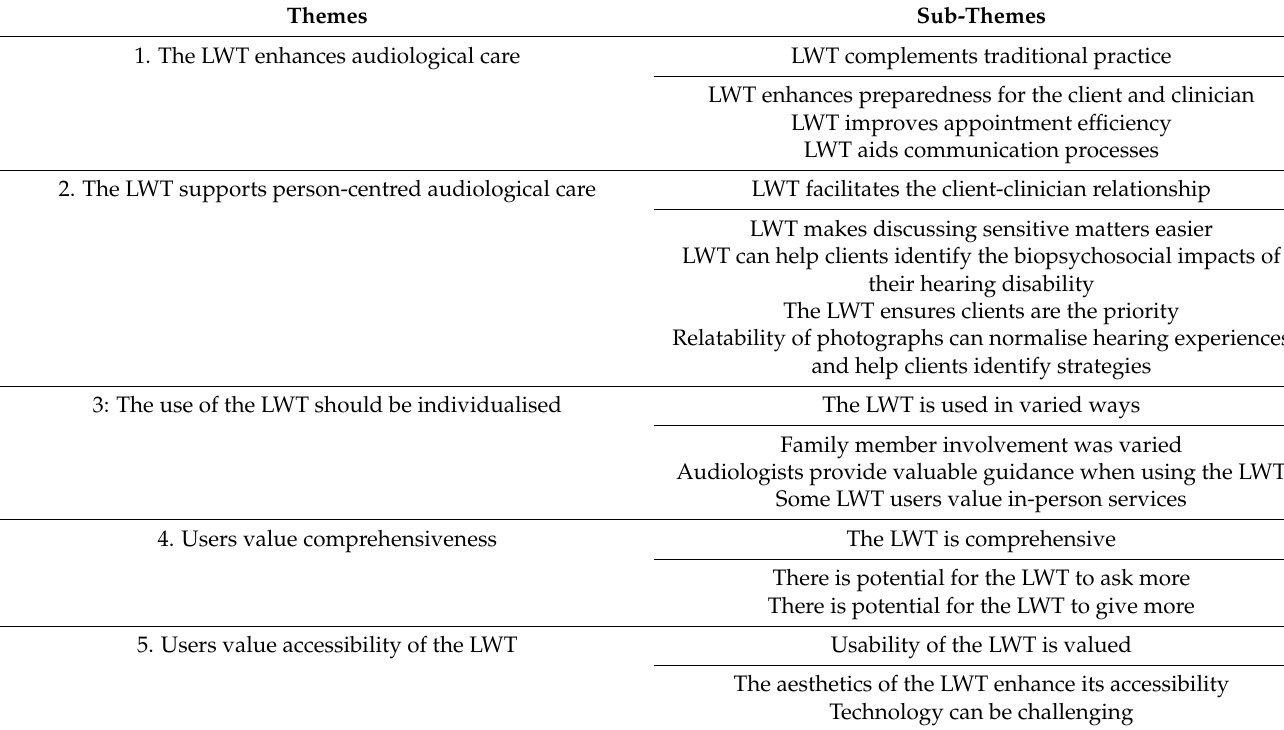
Table 1. Summary of themes and sub-themes 1: The LWT enhances audiological